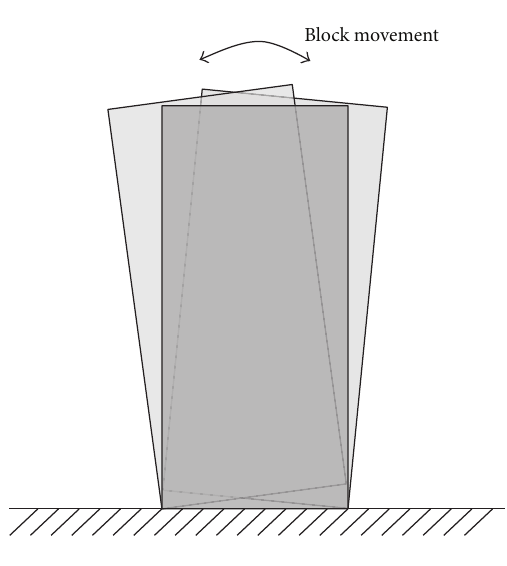
Figure 3: An old masonry